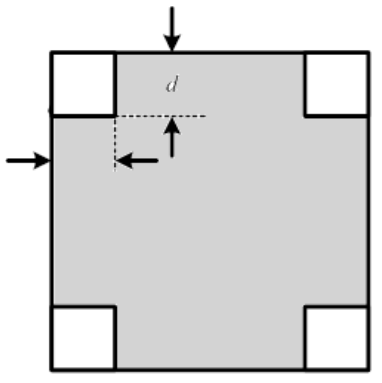
Figure 7. The shielding pattern of the PMCS.